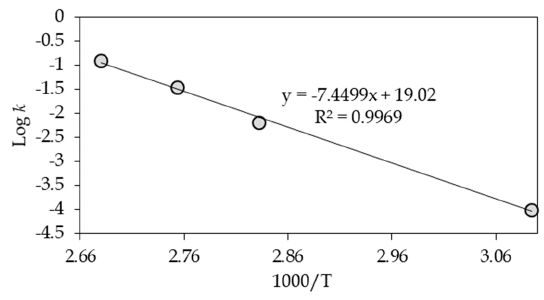
Figure 14. Logarithm of the apparent velocity constant versus the inverse of temperature.